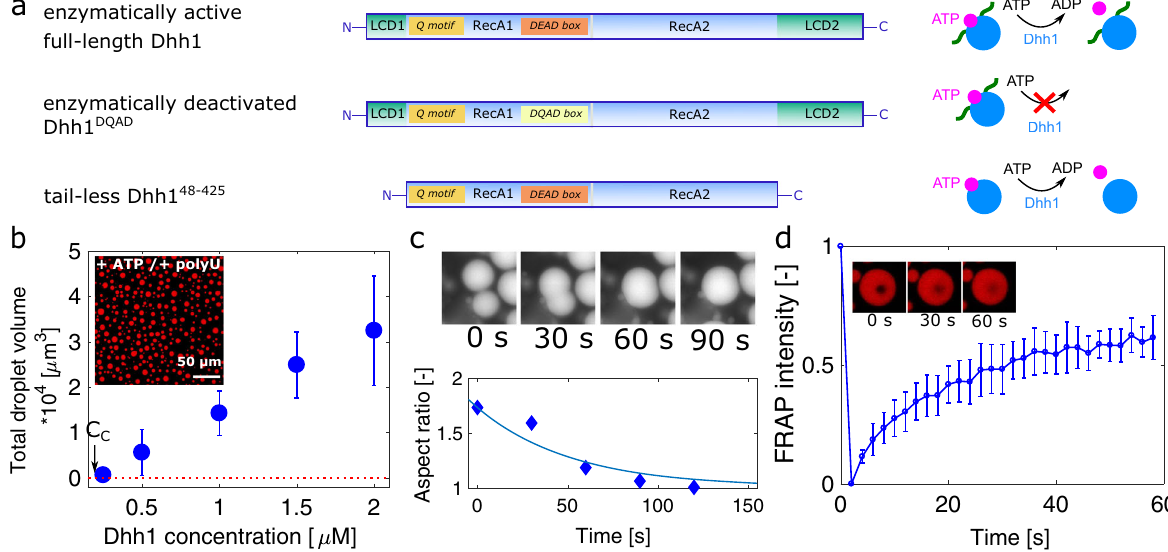
Fig. 1 In vitro phase separation of Dhh1. a Dhh1 variants used in this study: full-length Dhh1, consisting of two RecA domains as core, fl anked by an N- and a C-terminal low-complexity domain (LCD1/2). Q motif and DEAD box are important motifs to bind and hydrolyze ATP. In the Dhh1 DQAD variant, a single glutamate has been substituted with a glutamine, leading to an ATP hydrolysis-de fi cient variant, while the tail-less Dhh1 48 – 425 construct lacks both the N- and C-terminal LCD. b Effect of Dhh1 concentration on droplet formation. Dhh1 solutions at increasing protein concentrations were supplied with 5 mM ATP/MgCl 2 and 0.5 mg/ml polyU and imaged using wide fi eld fl uorescence microscopy providing a critical concentration (C C ) equal to 0.2 µ M. The panel shows the average total droplet volume of three different samples, with error bars representing the standard deviation. c Fusion and relaxation of two representative droplets into one single droplet, quanti fi ed by measuring the aspect ratio of two fusing droplets over time. d Mean FRAP signal of three different droplets of the droplets shown in ( b ), exhibiting recovery of 61 ± 2%. Error bars represent the standard deviation of the FRAP signal of three different droplets. Source data for panels b – d are provided in the Source Data fi